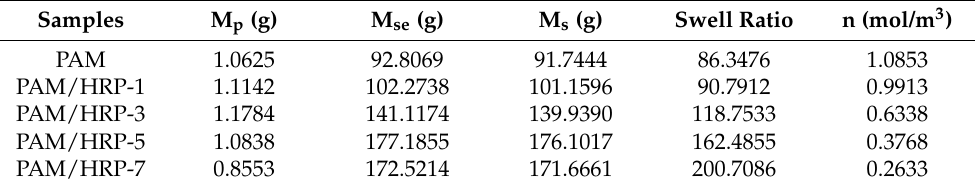
Table 3. The swelling property of PAM and PAM/HRP hydrogels.